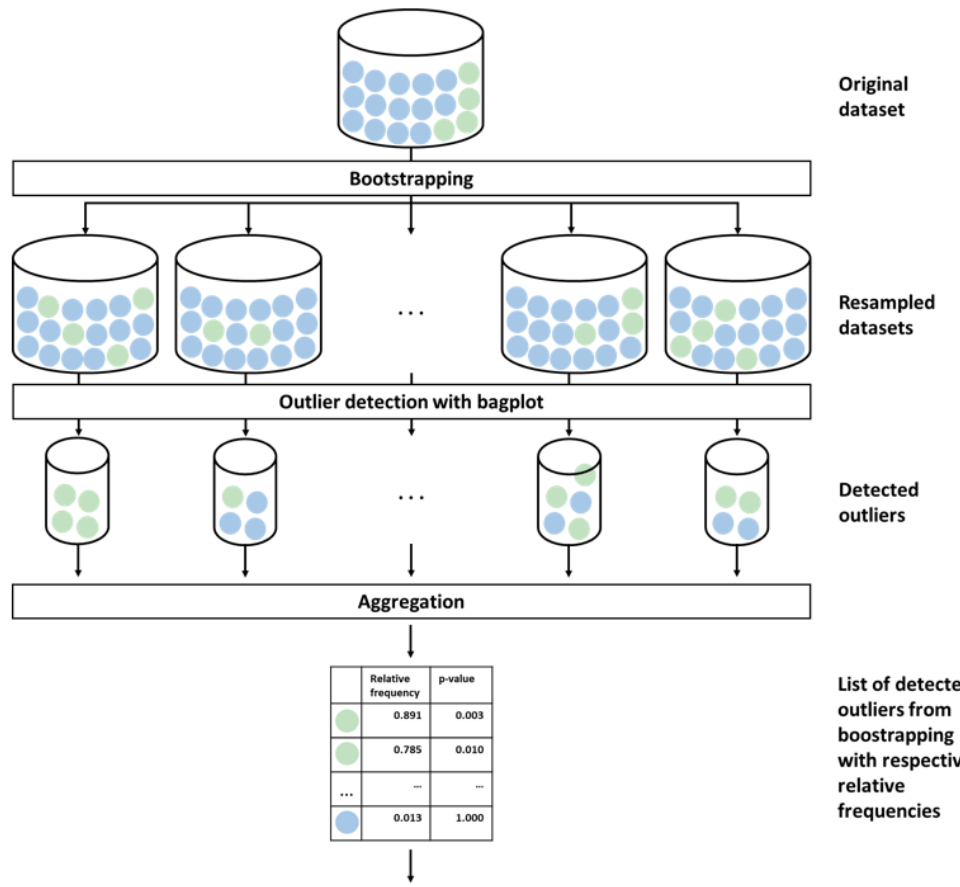
Figure 1. First part of the analysis pipeline: resampling and outlier detection. In the first step, the original dataset is resampled B times using random sampling with replacement. For each resampled dataset, outlier detection is conducted for the two study groups separately using bagplot or PCA-Grid algorithm. The samples marked as outliers for each bootstrap run were finally aggregated into relative frequencies, i.e., outlier probabilities. In addition, the p -value of the binomial test is